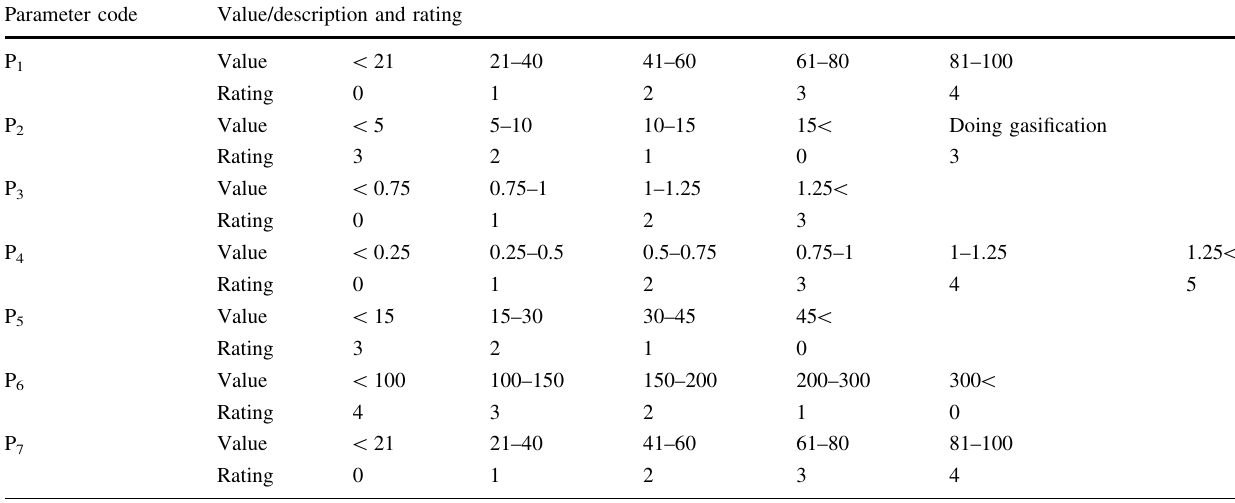
Table 5 Rating of the principal parameters effect in the advance operation or FAR Parameter